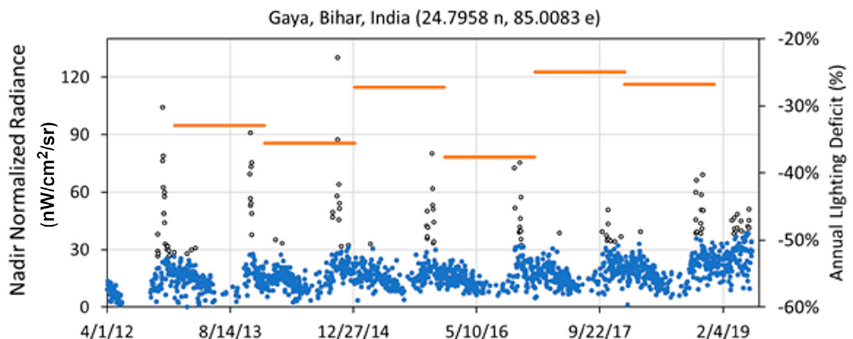
Figure 13. The % annual lighting deficit (orange horizonal lines) is the percent loss in monthly average radiances over a year relative to the brightest month. Open circles indicate anomalously bright radiances excluded from the analysis, associated with the annual Diwali holidays.